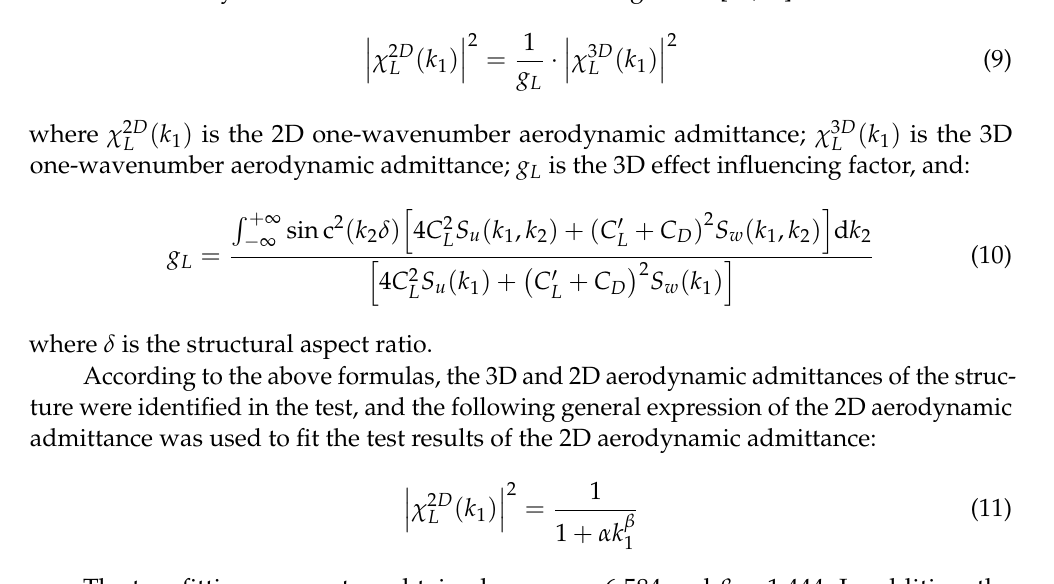
Figure 14. Aerodynamic derivative H ∗ 1 identification result.